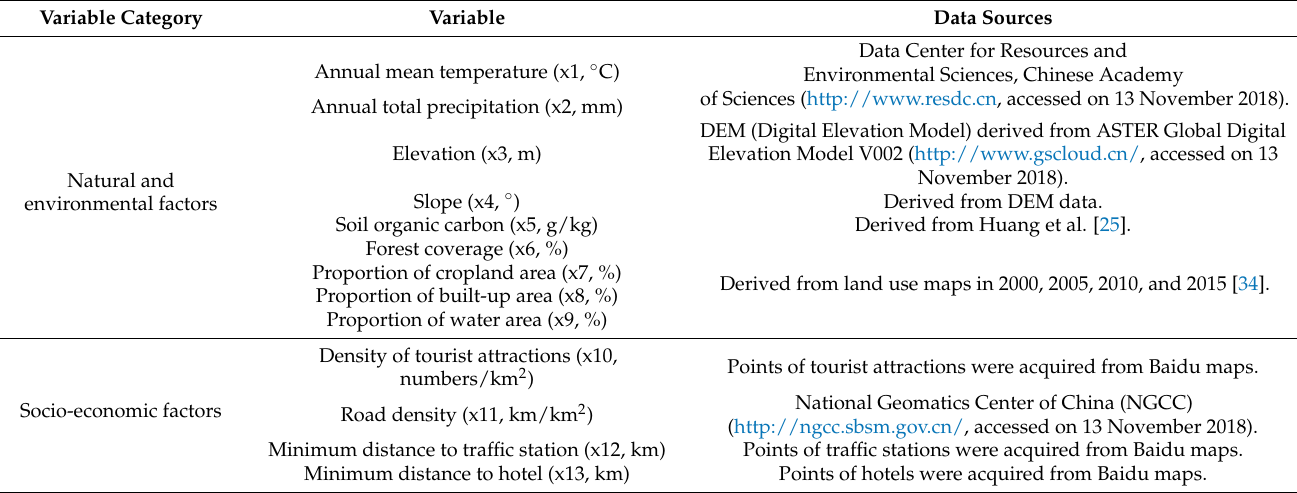
Table 1. Index system for assessing recreation